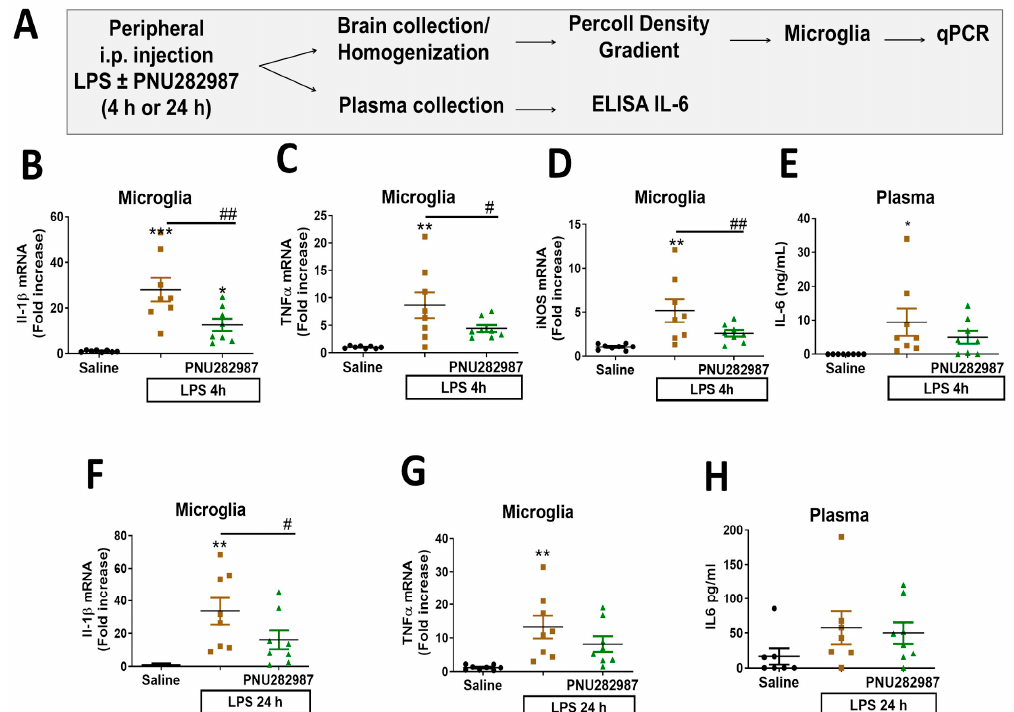
Figure 2. - α 7 nAChR activation by co-administration of PNU282987 and LPS via i.p. prevents microglial pro-inflammatory cytokine expression. ( A ) Schematic representation of the experimental procedure used. ( B ) Plasma levels of IL-6 4 h after injections. Microglial mRNA levels of IL-1 β ( C ), TNF α ( D ) and iNOS ( E ) 4 h after the different treatments indicated in the X axis. ( F ) Plasma levels of IL-6 24 h after LPS ± PNU282987 injections. Microglial mRNA expression of IL-1 β ( G ) and TNF α ( H ) 24 h after injections. Data represent the mean and S.E.M. eight animals per group. Comparisons were made using one-way ANOVA. * p < 0.05, ** p < 0.01, *** p < 0.001 vs. saline; # p < 0.05, ## p < 0.01 vs.